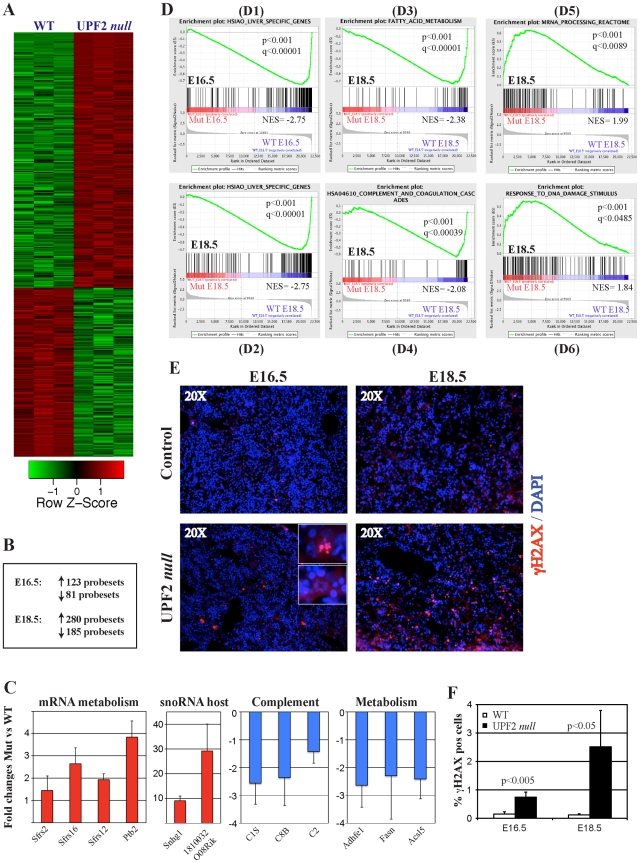
Gene expression analysis of control and UPF2 null fetal livers.(A) Cluster analysis of normalized affymetrix expression data from control and UPF2 null E18.5 fetal livers. (B) Summaries of deregulated probesets at E16.5 and E18.5 in control vs UPF2 null fetal livers. (C) qRT-PCR validation of deregulated genes belonging to different functional classes in E18.5 UPF2 null fetal livers. Red and blue colors indicate up-regulated and down-regulated genes, respectively, in UPF2 null fetal livers. cDNA was synthesized from 3 mice of each genotype and assayed by qPCR in triplicates (mean +/− standard deviation). (D) Selected enriched gene sets from GSEA analysis. D1-D2: HSIAO_Liver_Specific_Genes, D3: Fatty_Acid Metabolism, D4: HSA04610_Complement_And_Coagulation_Cascades, D5: mRNA_Processing_Reactome, D6: Response_to_DNA_Damage_Stimulus. Normalized enrichment scores, p-value and q-values (FDR) are indicated for each gene set. Negative and positive NES values indicate enrichment in control and UPF2 null fetal livers, respectively. Y-axes indicate Enrichment scores (top) and Ranked list metric (bottom). Green lines indicate enrichment profile, black bars are hits (i.e. genes) and grey profiles are ranked metric score. Red and blue indicate positive and negative correlations, respectively, with the indicated gene sets. (E) Immunofluorescence analysis of control and UPF2 null fetal livers demonstrate the accumulation of nuclei positive for the DNA Damage marker γH2AX upon loss of UPF2. Insert shows a close-up on two nuclei with abnormal morphology, one of them being positive for γH2AX. (F) Quantification of the data in (E). The data represent quantification of at least 2000 cells from 3 different individuals of each genotype at each of the two time points (mean +/− standard deviation).